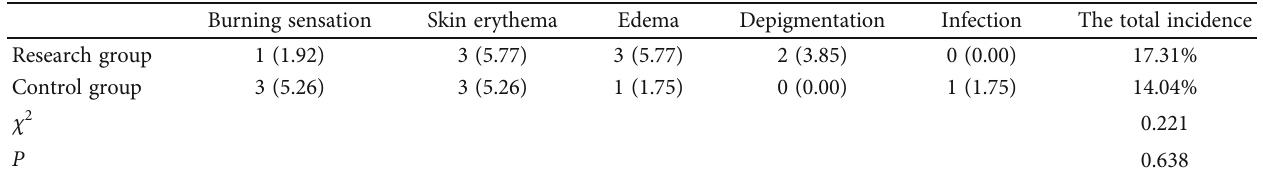
Table 3: Comparison of the incidence of adverse reactions ½ n ð % Þ(cid:2)